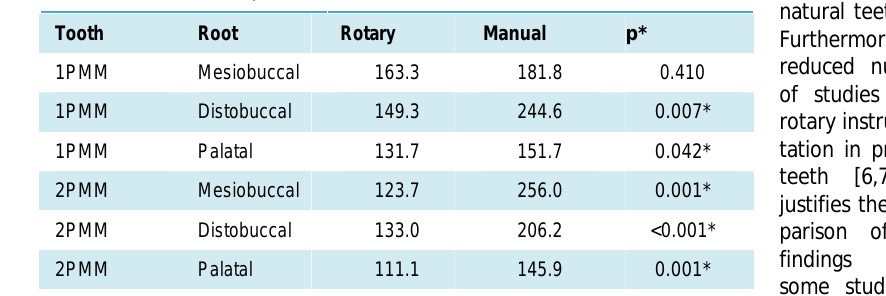
Table 3: Analysis of time (in seconds) comparing the techniques used (rotary vs. manual